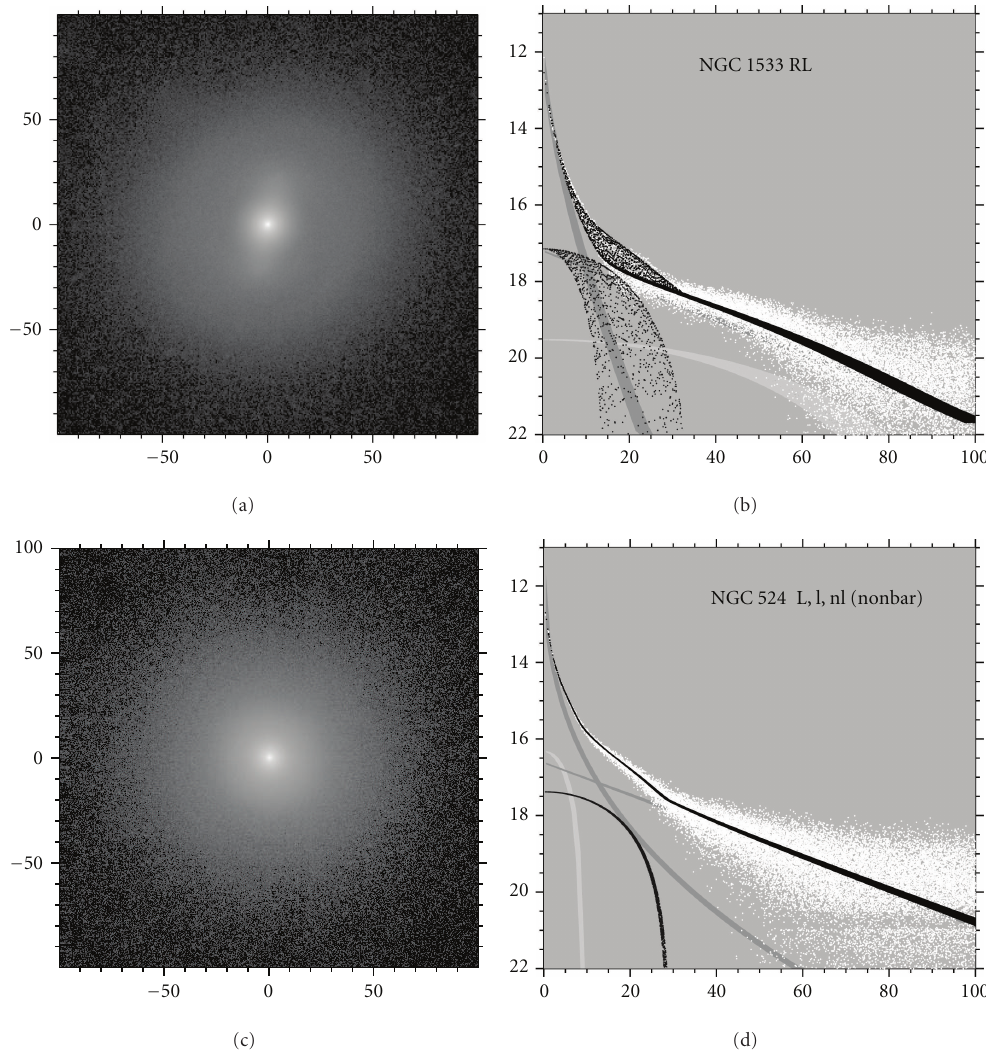
Figure 6: Examples of nonbarred lens galaxies. (a, c) show the images, whereas (b, d) show the 2-dimensional surface brightness profiles, in which overplotted are the fitted functions to the structural decompositions, as well as the total model. White dots are for the image pixel values, and the black lines/dots are for the total model. Models for the bulges are shown by dark grey lines and the models for the lenses by light grey and black dots in the inner regions. For example, in NGC 524 the two curved inner components are the nuclear lens (nl) and lens (l), and the outer exponential function fits the outer lens (L). This figure was originally published by Laurikainen et al.